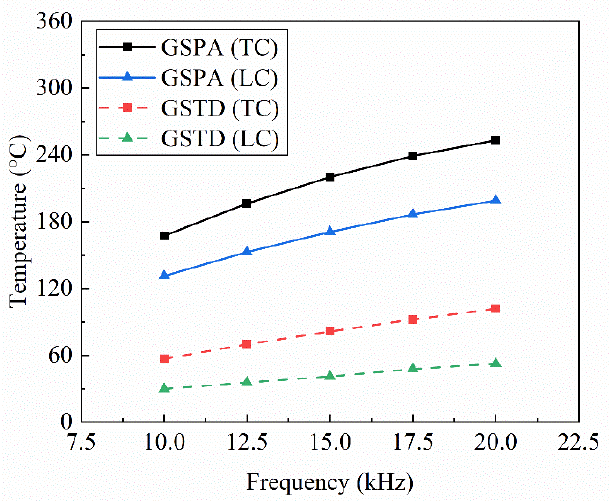
Figure 7. Effect of current intensity on temperature distribution.